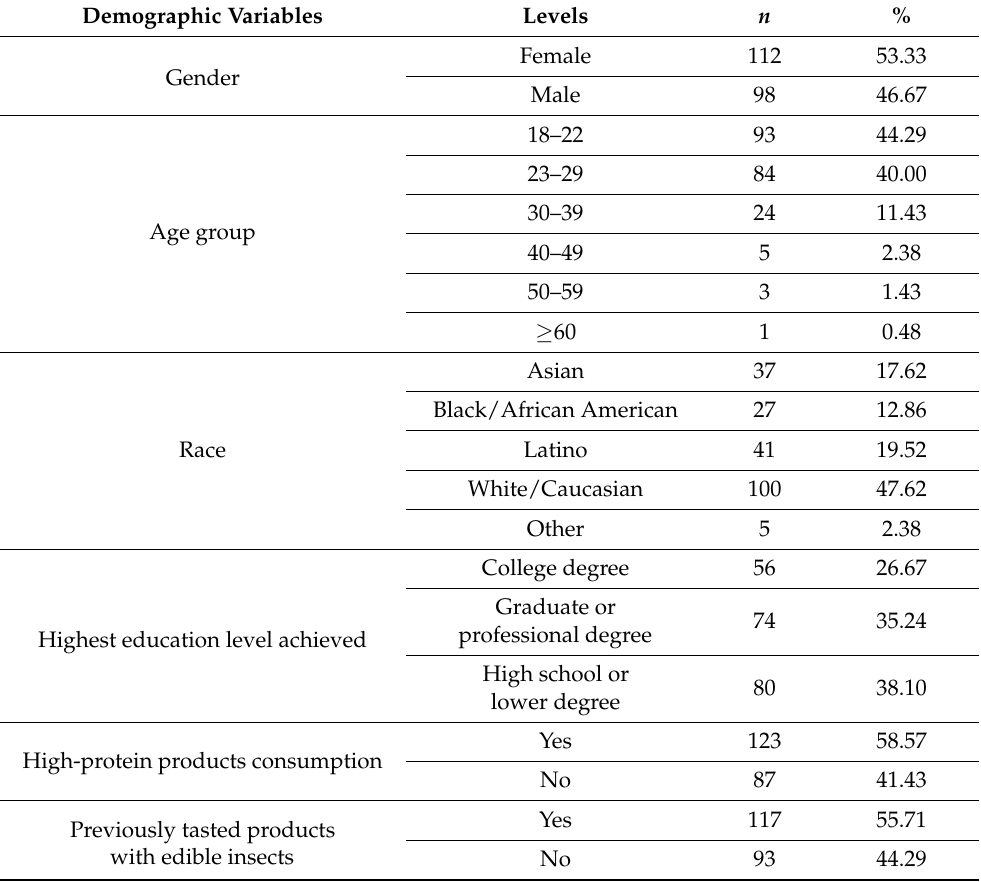
Table 1. Demographic profile of participants from the consumer